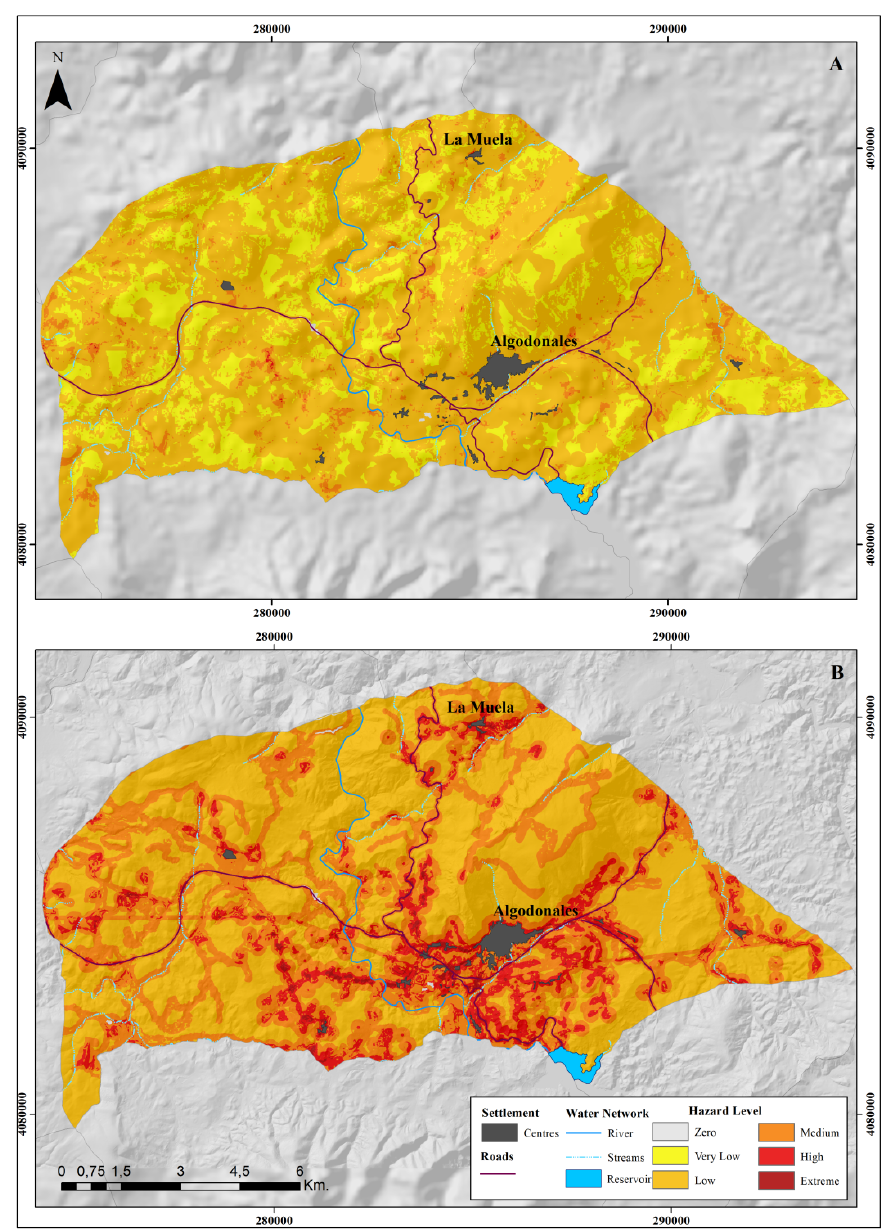
Figure 9. Final hazard map (natural + induced). A . 14 January 2013. B . 25 July 2013.